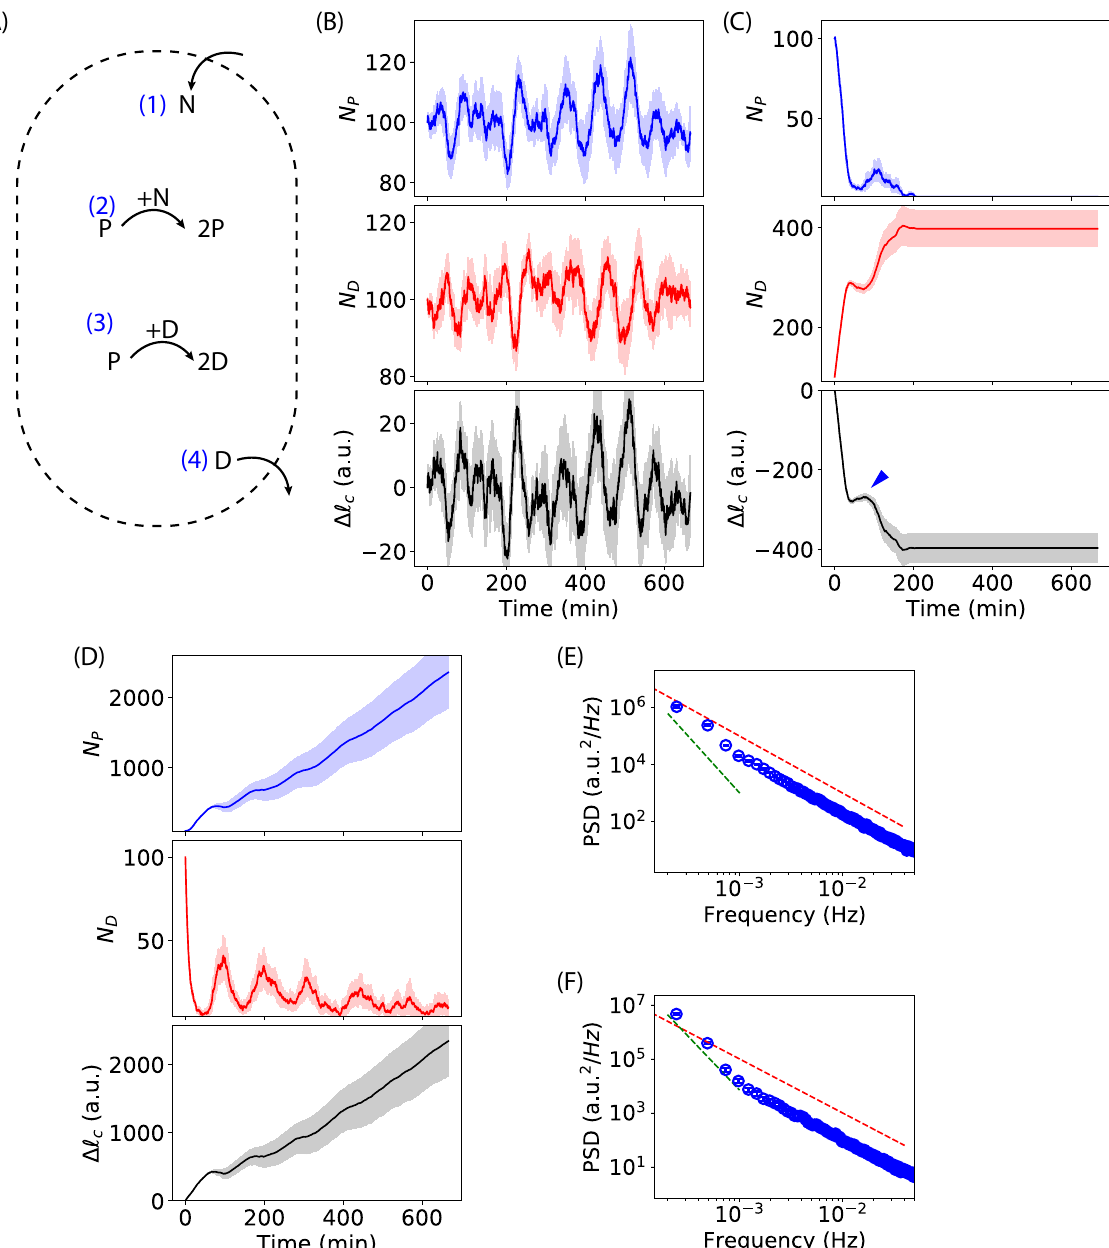
Figure 4. Predator-prey-like model. ( A ) Illustration of the components and dynamics of the system in our model. The “reactions” (1)–(4) in the system are described in the text. ( B ) Simulated oscillation of cell-length with simulation parameters ( r i = 0.1 s − 1 , r g = 10 − 5 s − 1 , r d = 10 − 5 s − 1 , and r o = 10 − 3 s − 1 ) and initial conditions ( N N 0 = 100, N P 0 = 100, and N D 0 = 100). ( C ) Simulated cell shrinkage with the same initial conditions and parameters as in ( B ) except r o = 10 − 4 s − 1 . ( D ) Simulated cell growth with the same initial conditions and parameters as in ( B ) except r o = 3 × 10 − 3 s − 1 . The dark lines in ( B–D ) are averages of 10 simulations, while the light areas stand for the standard errors of the means. ( E,F ) Power spectral densities of simulated cell-length curves with the same initial conditions and parameters as in ( B , D ). The red dashed line indicates a slope of − 2, while the green dashed line indicates a slope of − 4 in the log-log